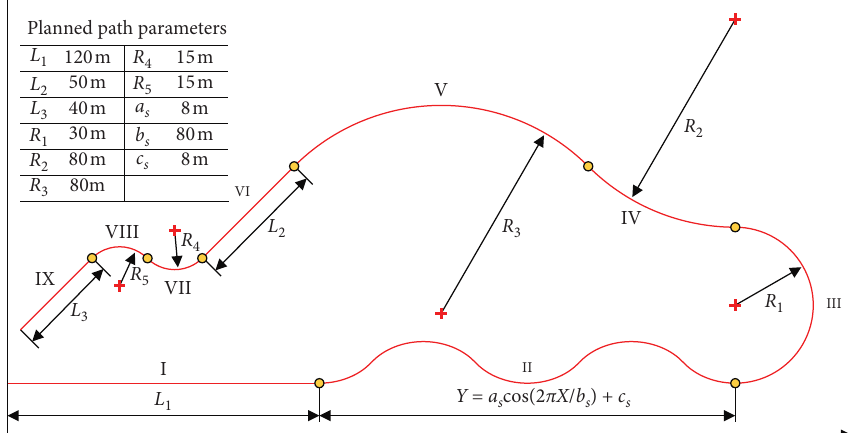
Figure 18: Schematic of a complex path.